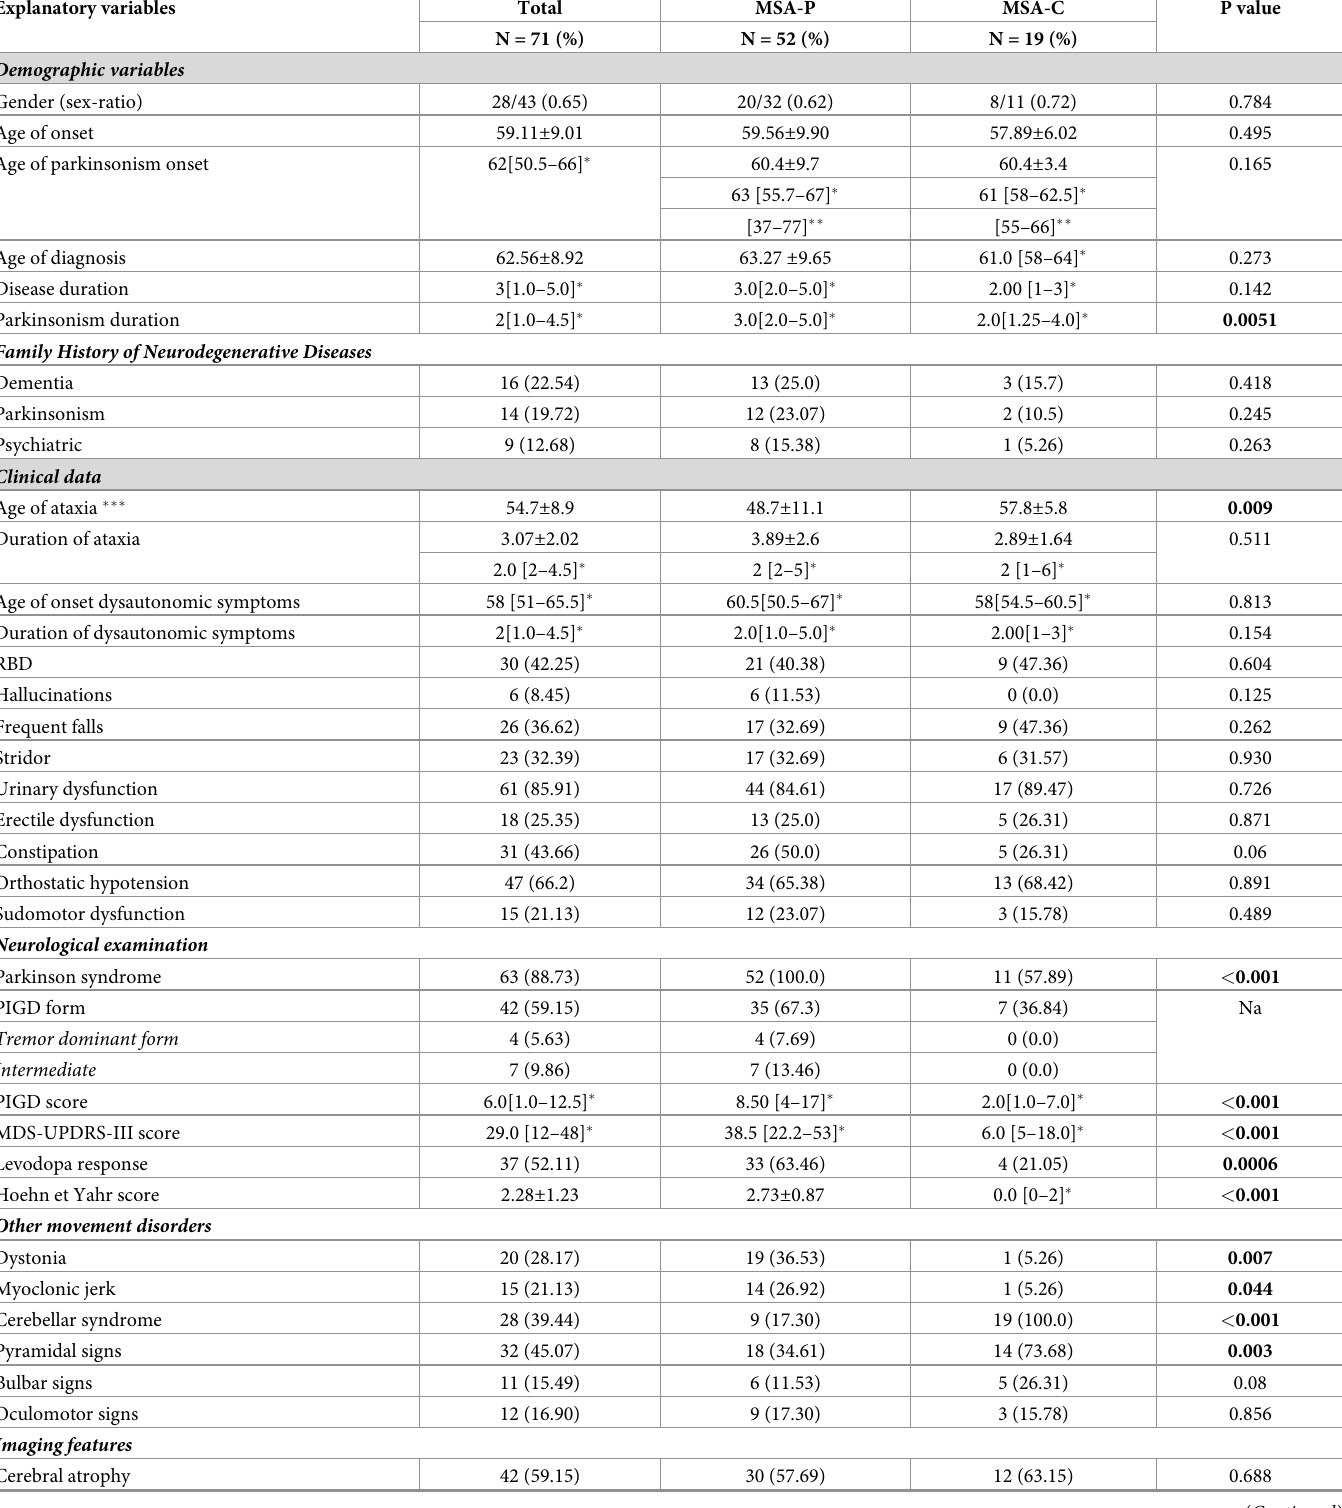
Table 1. Demographic, clinical and imaging data in MSA patients and motor